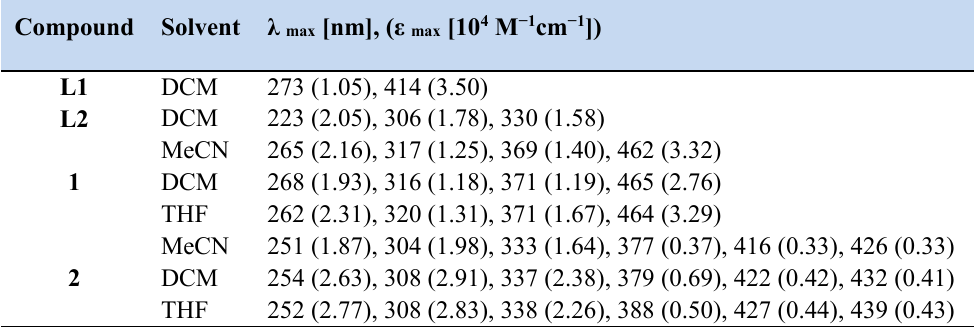
Table 2. Electronic absorption data for complexes 1 and 2 in different solvents.